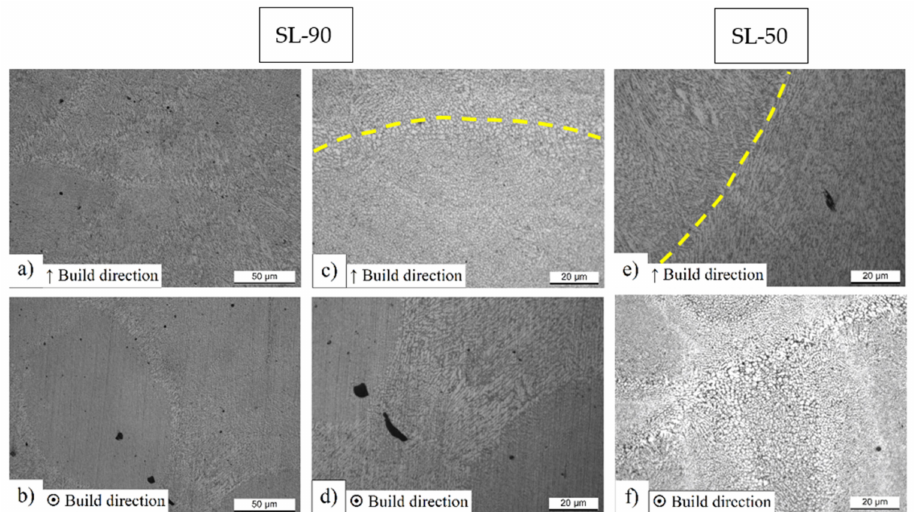
Figure 2. High magnification micrographs of as-built AlSi10Mg 90-samples in XZ plane ( a , c ) and XY plane ( b , d ), and of as-built AlSi10Mg 50-samples in XZ plane ( e ) and XY plane ( f